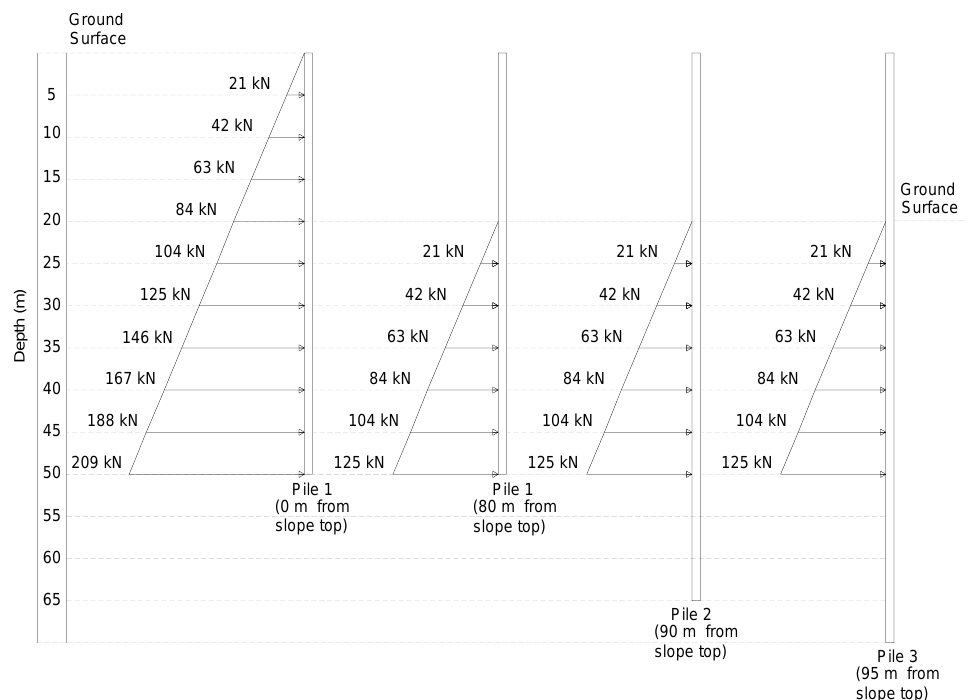
Figure 13. Examples of kinematic forces using the proposed method.